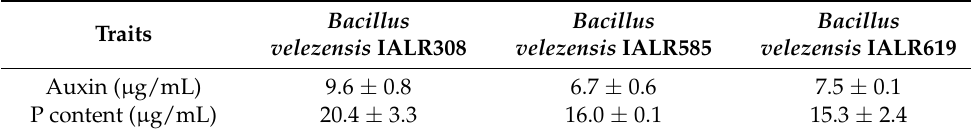
Table 2. Plant growth-promoting traits of selected bacterial endophytes. Traits